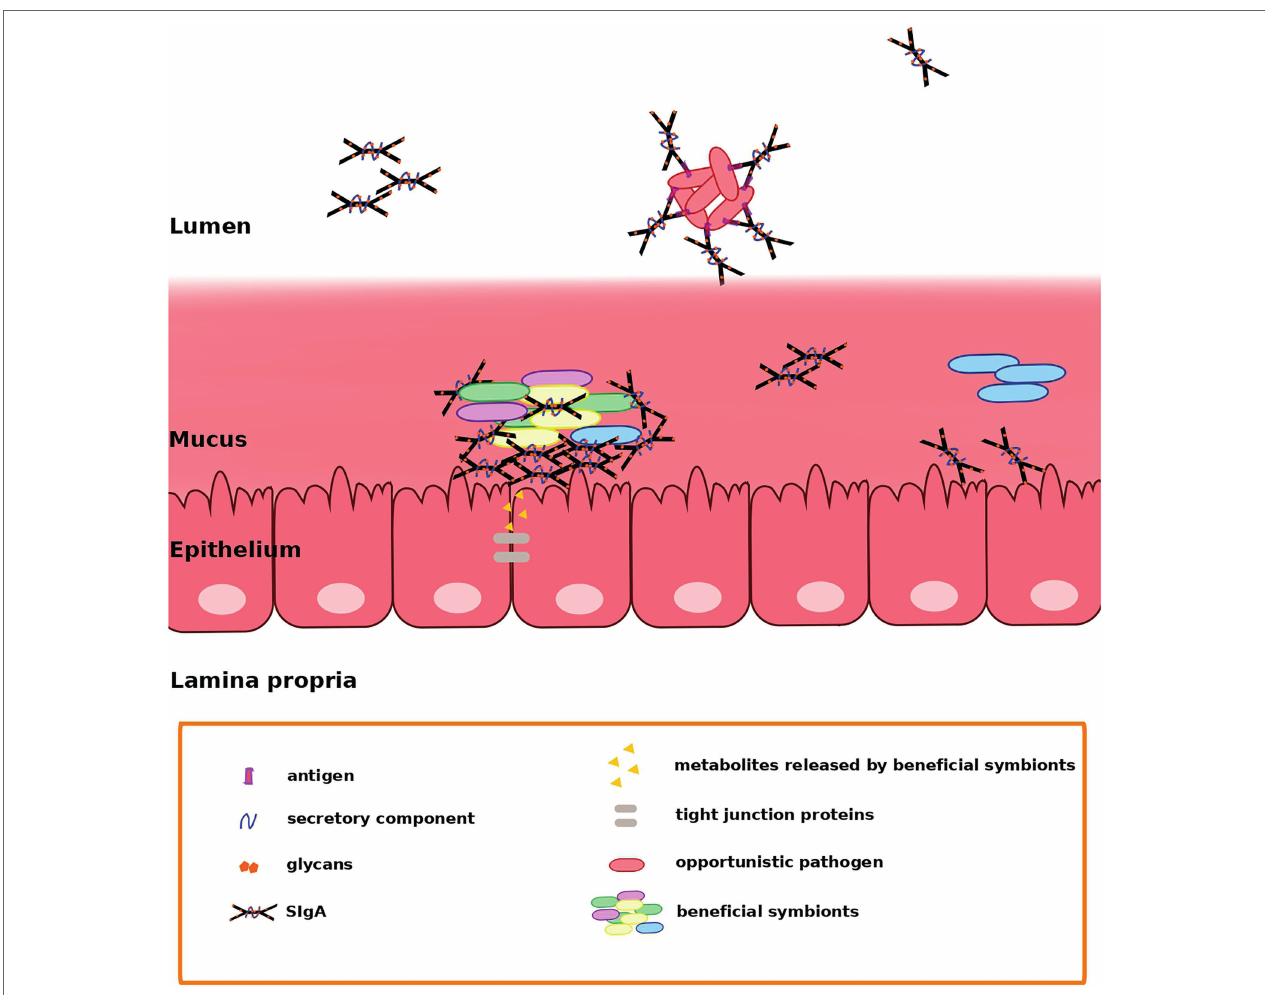
FIGURE 1 | Secretory immunoglobulin A (SIgA) may favor the retention of beneficial members of the gut microbiota and the clearance of opportunistic pathogens through different modes of binding. Fab-dependent (canonical) binding may serve mainly to control microbiota members that may act as opportunistic pathogens, avoiding their penetration into the mucus. On the other hand, noncanonical binding may support the establishment of Bacteroides and Gram-positive symbionts in the mucus, maybe by contributing to the formation of a scaffold linking bacteria together and anchoring them to the underlying epithelium (Mathias and Corthésy, 2011). Nevertheless, direct interaction between epithelial cells and bacteria is prevented, avoiding an aggressive response by the immune system. Extracellular and intracellular receptors in epithelial cells recognize metabolites released by the gut microbiota, triggering the NF κ B pathway and inducing an increased phosphorylation of tight junction